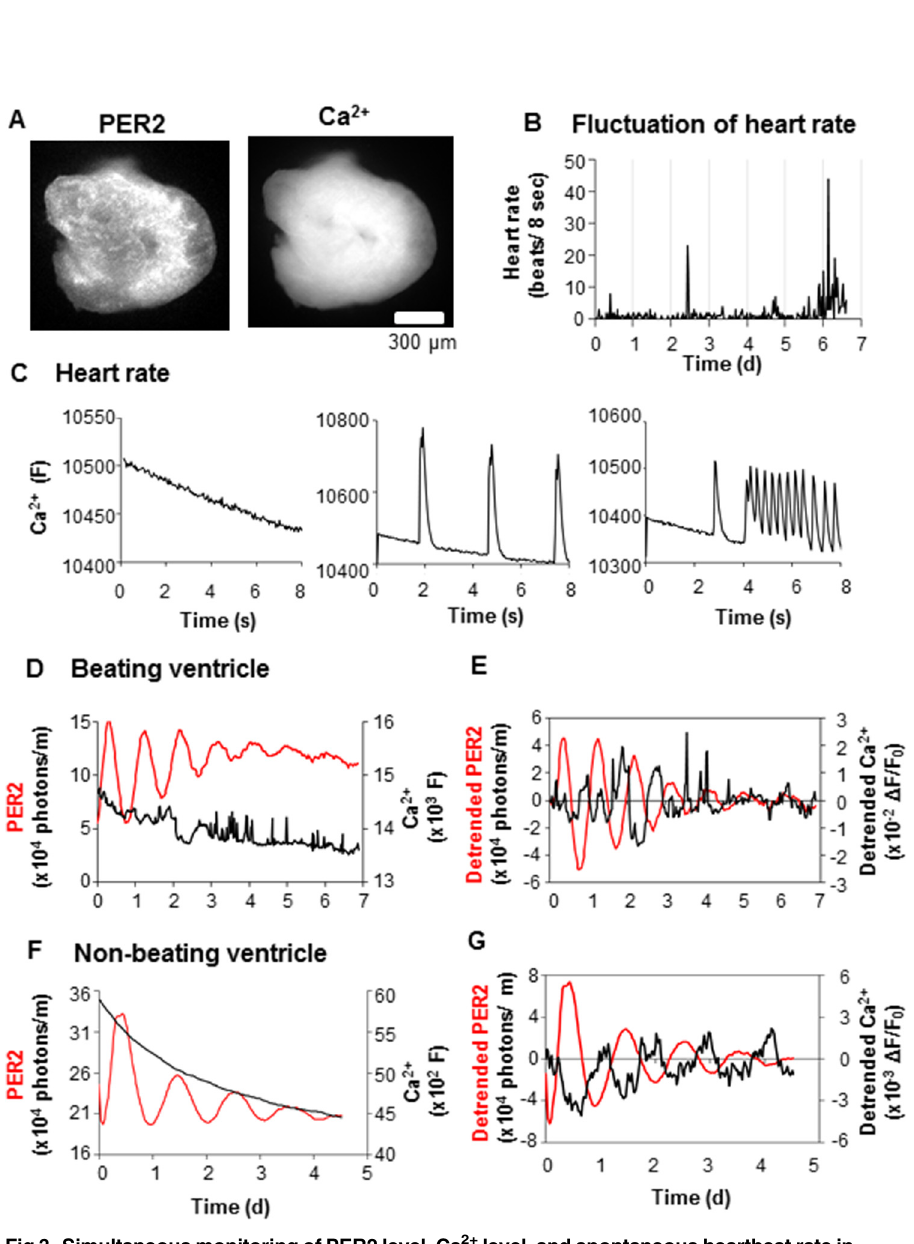
within a culture are shown on the x-axis. Filled black bars represent dispersed cardiomyocytes. Open white bars represent ROIs in ventricle explants.